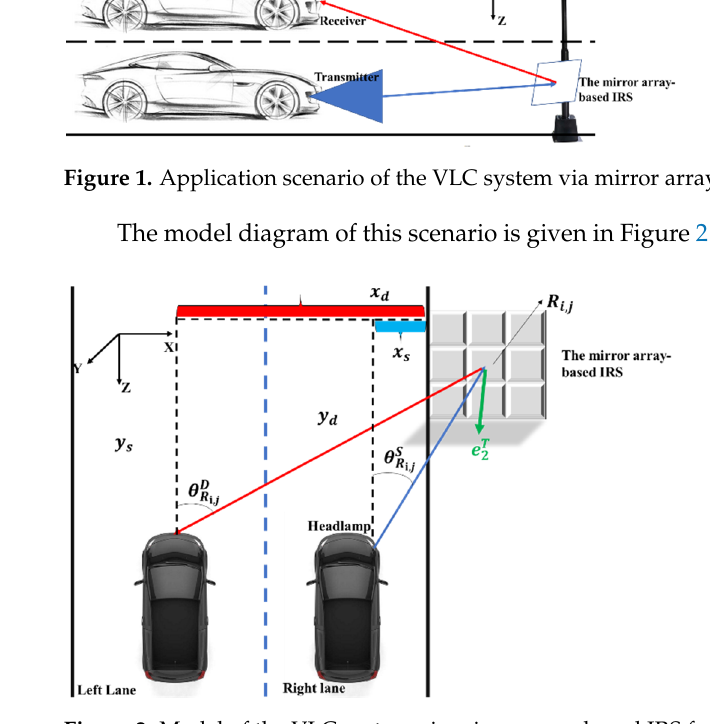
Figure 2. Model of the VLC system via mirror array-based IRS for parallel vehicles. For the mirror array-based IRS, the rotation angle of each mirror in the IRS can be controlled independently without interfering with others. One of the mirrors is analyzed